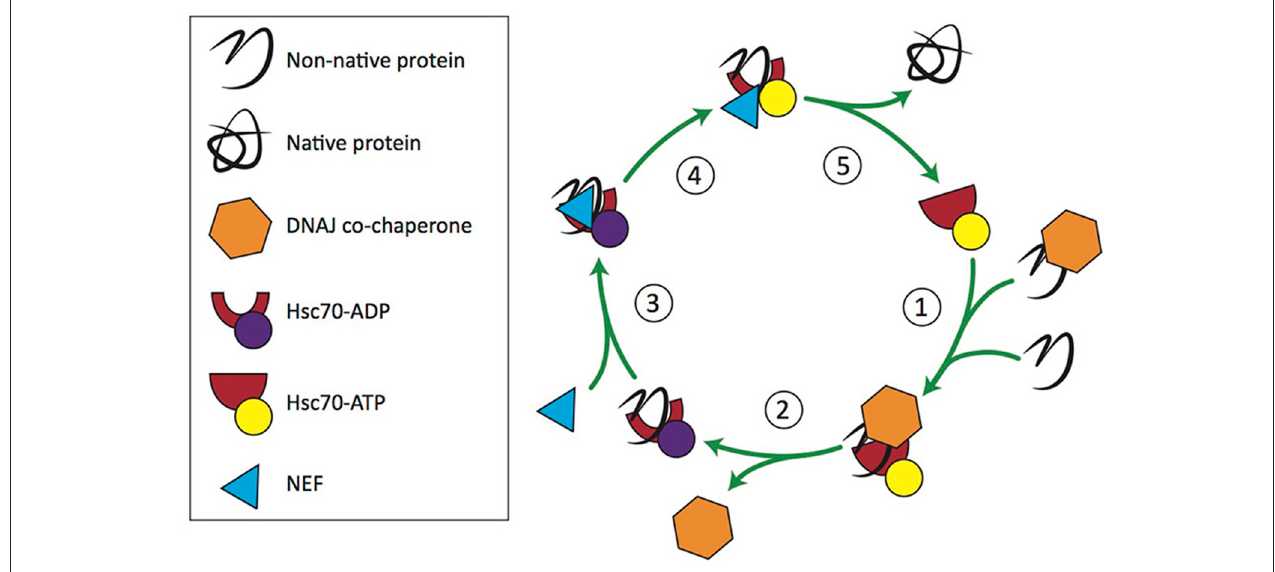
FIGURE 1 | Hsc70/DNAJ co-chaperone cycle. 1. Free clients or those recruited by DNAJ bind Hsc70-ATP. 2. DNAJ stimulates Hsc70’s ATPase activity. 3. An Hsc70 nucleotide exchange factor (NEF) binds Hsc70-ADP. 4. NEF stimulates ADP-ATP exchange. 5. Hsc70-ATP releases the client and enters a new round of chaperone